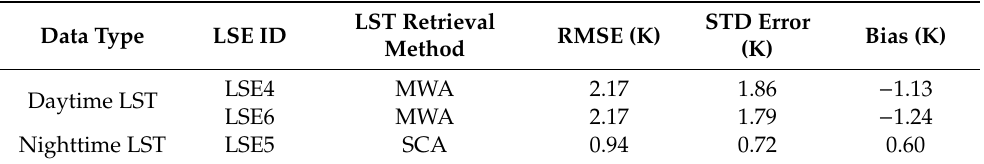
Table 4. Validation test of Landsat 8 LST retrieval at the nine ground stations: The best LST methods and LSE models and accuracy results for daytime and nighttime